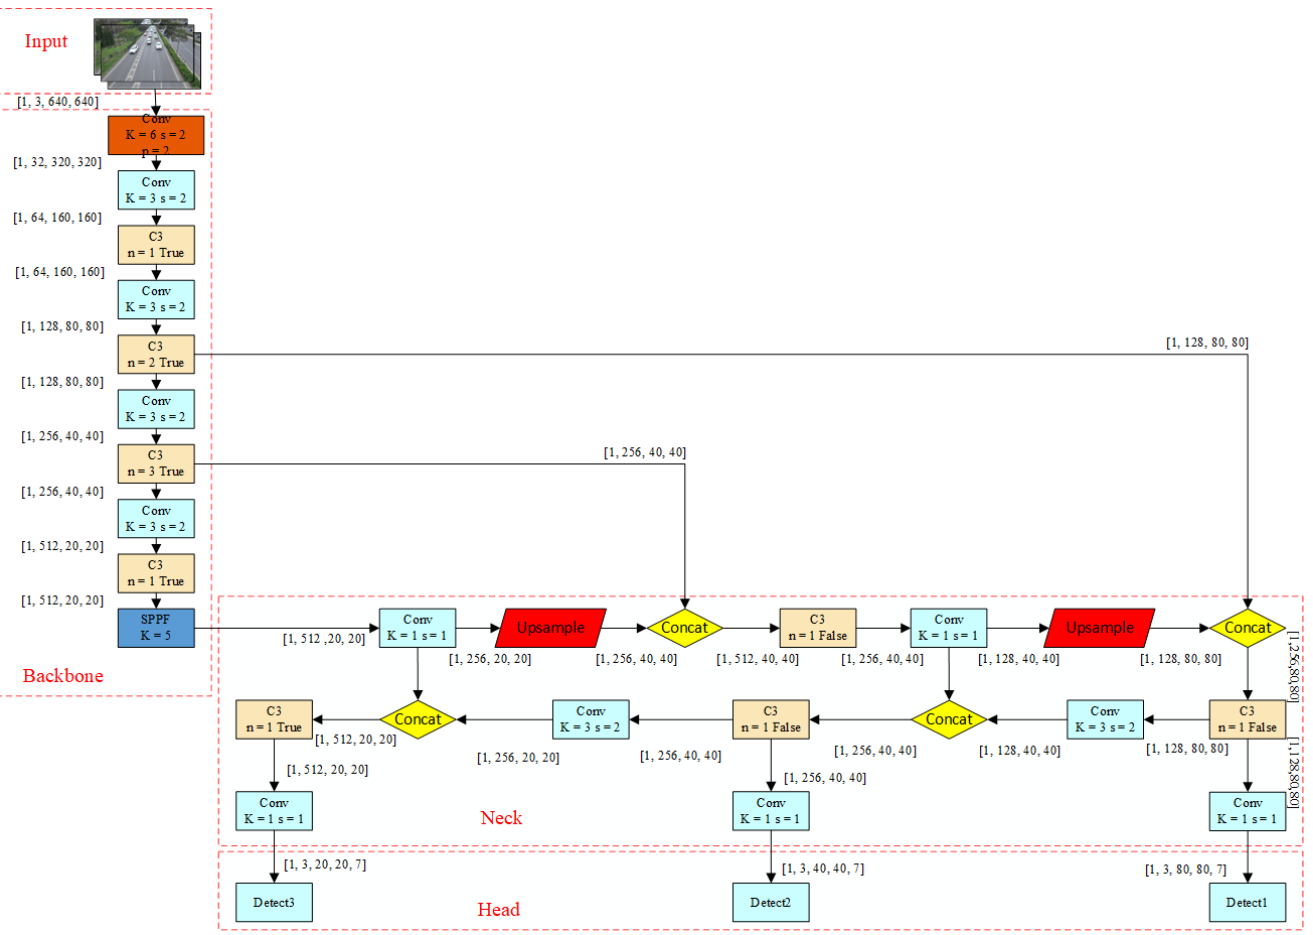
Figure 1. The structure of the YOLOv5.